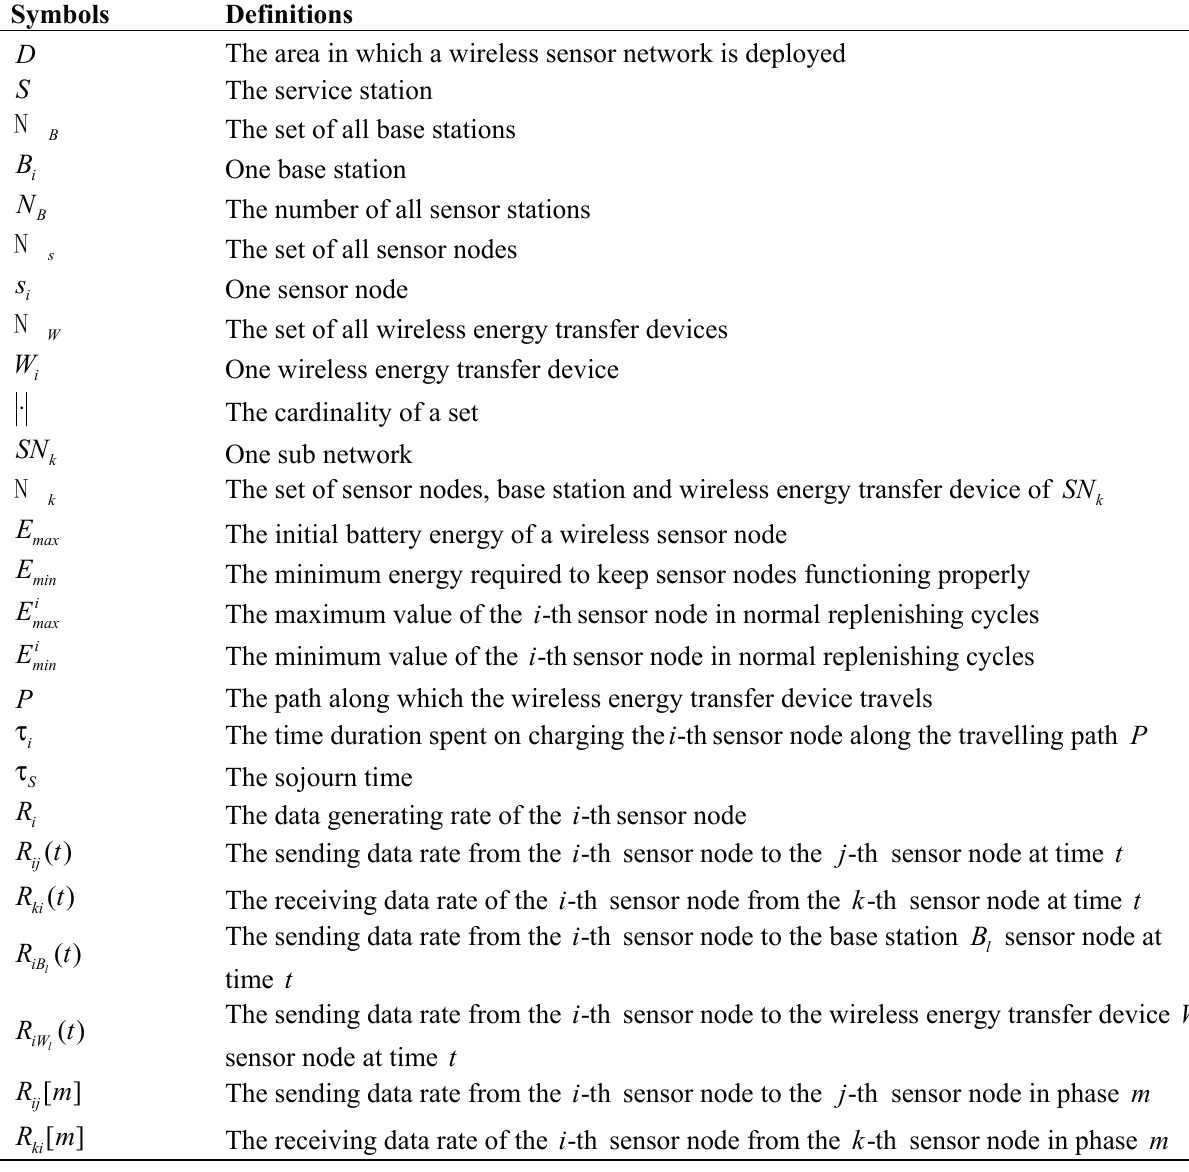
Table 1. The symbols used in the